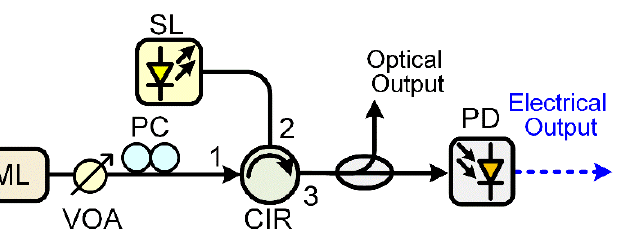
Figure 1. Schematic diagram of an optical injection system. ML: master laser; SL: slave laser; VOA: variable optical attenuator; PC: polarization controller; CIR: optical circulator; PD: photodetector.